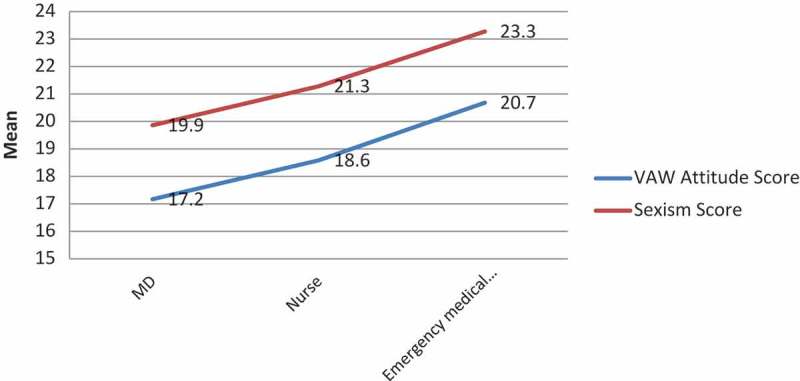
Distribution of the VAW attitude and sexism scores according to occupations.